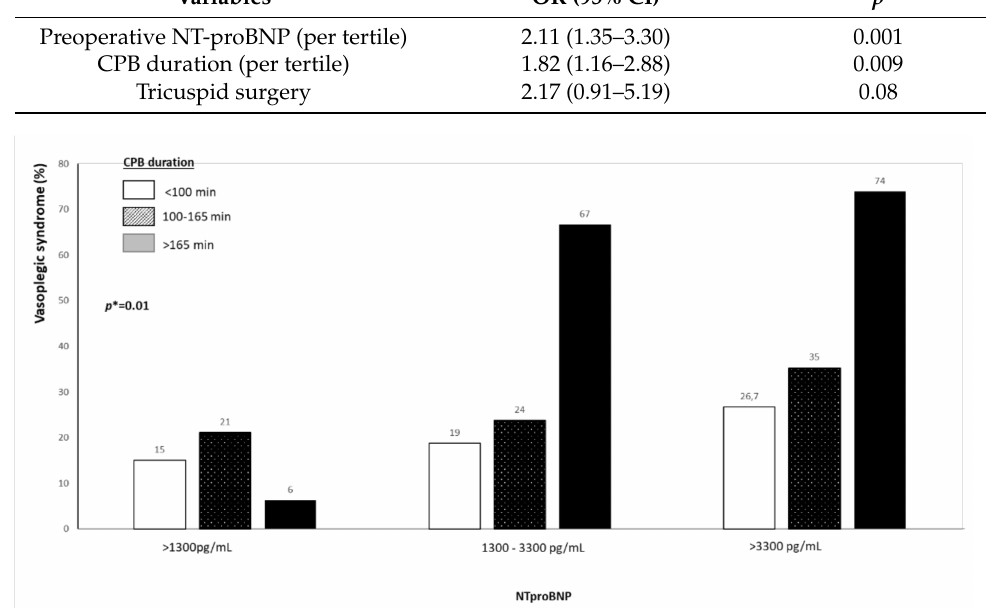
Figure 1. Incidence of vasoplegic syndrome according to NtproBNP value and cardio-pulmonary bypass duration, p * indicates the interaction term between Nt-proBNP and CPB